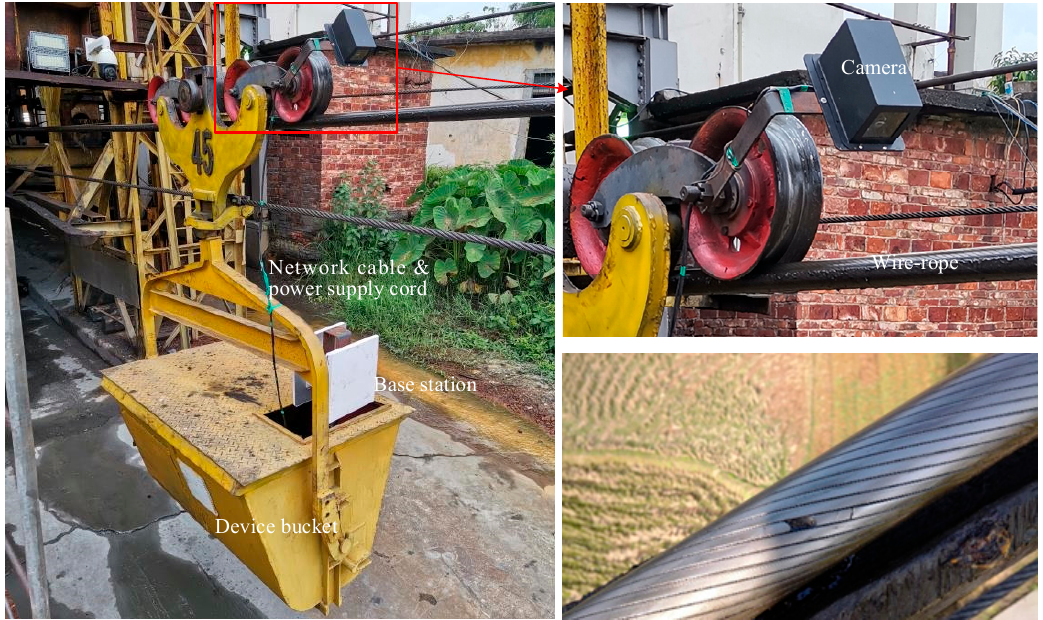
Figure 2. System structure of the hauling rope flaw detection in mine cableways.